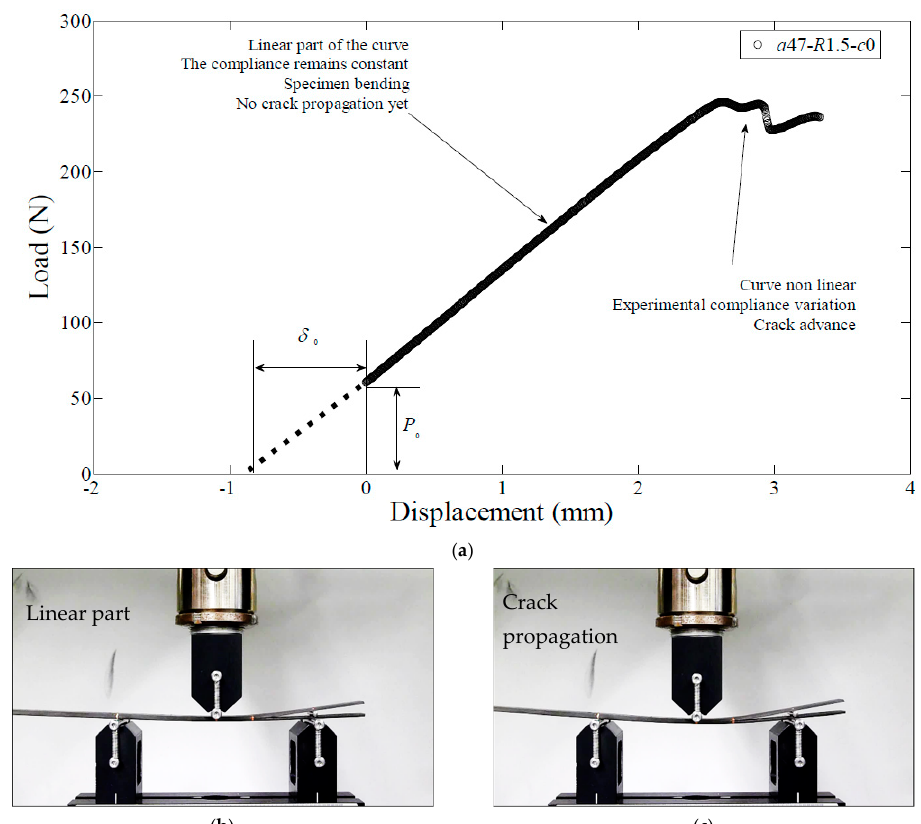
Figure 7. Test steps during and ENFR mixed-mode test: ( a ) Experimental load-displacement curve; ( b ) Photograph of a step of the linear part of the test; ( c ) Photograph of a step during crack propagation.